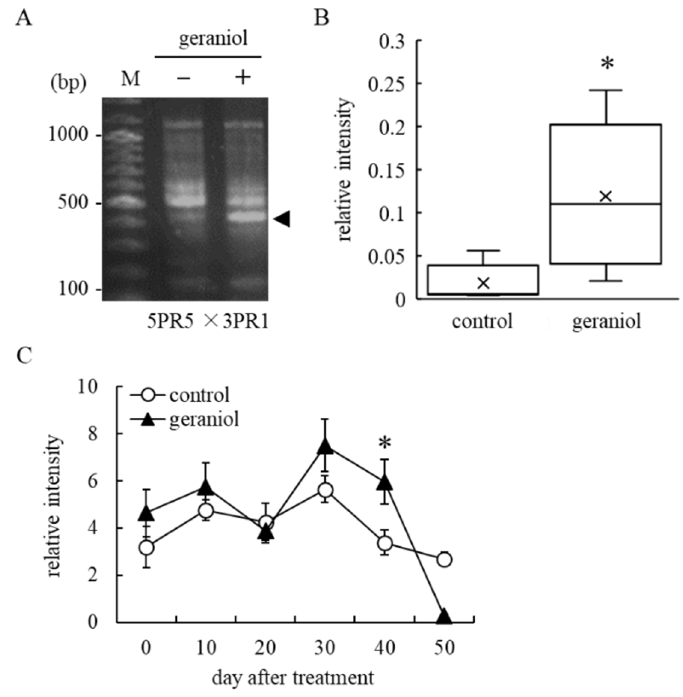
Figure 5. Upregulation of VvABCG40 transcription by geraniol treatment in grape cultured cells and grape berry skins. ( A ) RT-PCR-based differential display. Upregulation of VvABCG40 transcription (arrowhead) in response to geraniol was detected in geraniol-treated VR cells. M, 100 bp DNA ladder marker. +, geraniol treatment. –, no treatment. Numbers on the left indicate the positions of DNA molecular size markers. ( B ) Transcription levels of VvABCG40 in VR cells. Transcription levels of VvABCG40 in geraniol-treated or control cells were estimated by real-time RT-PCR. Data were calculated as gene expression relative to β-actin expression. Bars indicate means ± standard errors of five independent experiments. ×, means. ( C ) Transcription levels of VvABCG40 in berry skins of field-grown grapevines. Transcription levels of VvABCG40 in berry skins collected from geraniol-treated or control bunches of field-grown grapevines were estimated by real-time RT-PCR. Data were calculated as gene expression relative to β-actin expression. Bars indicate means ± standard errors for four bunches. * p < 0.05 compared with control. Geraniol, treated with 10 nM geraniol. Control, treated with diluted ethanol.